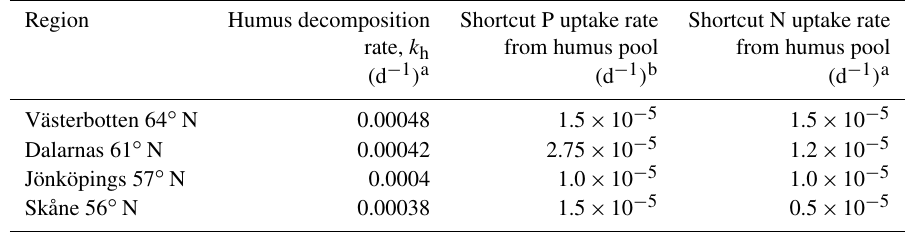
Table 2. Parameters with specific values for different